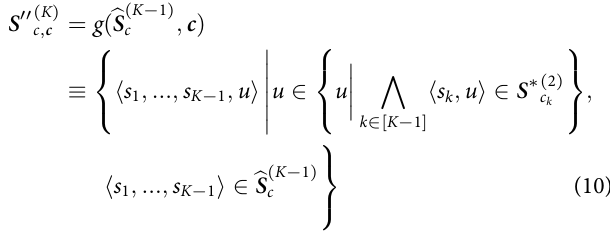
ALGORITHM 1 | Brute-Force Search